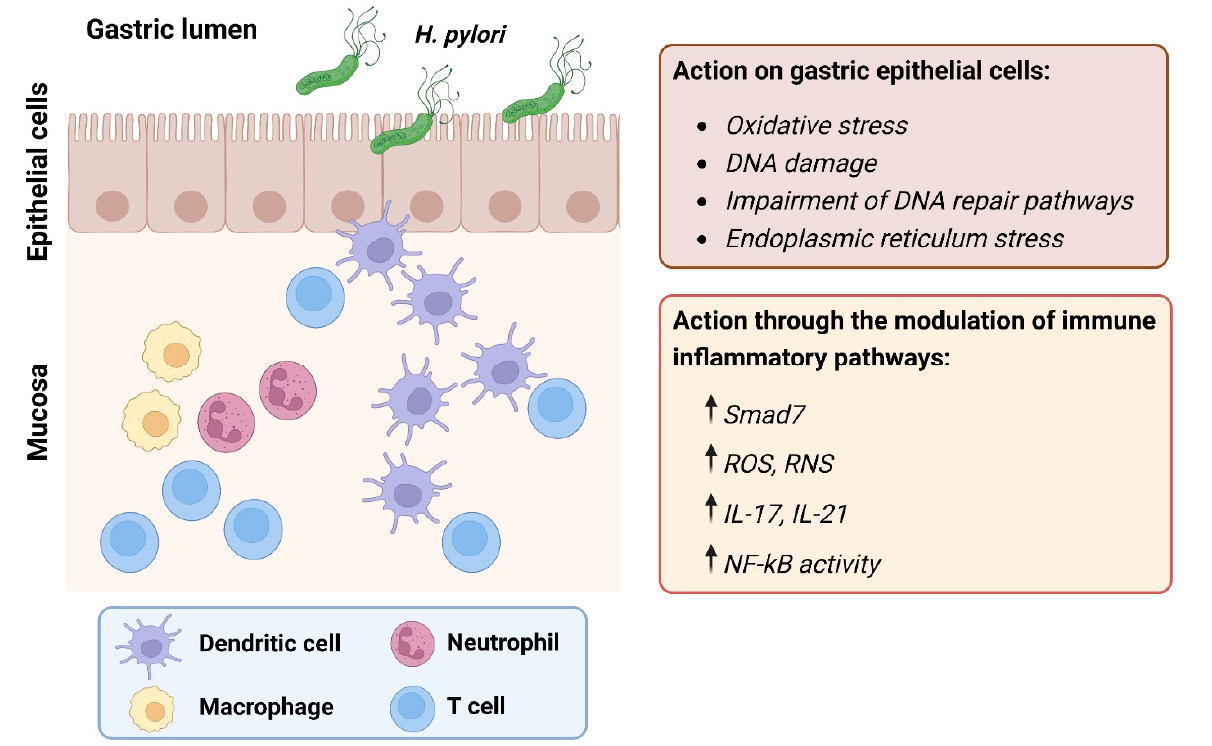
Figure 1. Direct and indirect actions of Helicobacter pylori ( H. pylori ) on gastric epithelial cells during gastric carcinogenesis. Abbreviations : Smad7: suppressor of mothers against decapentaplegic 7; ROS: reactive oxygen species; RNS: reactive nitrogen species; IL: interleukin; NF- ĸ B: nuclear factor kappa-light-chain-enhancer of activated B cells. Created with Biorender.com.